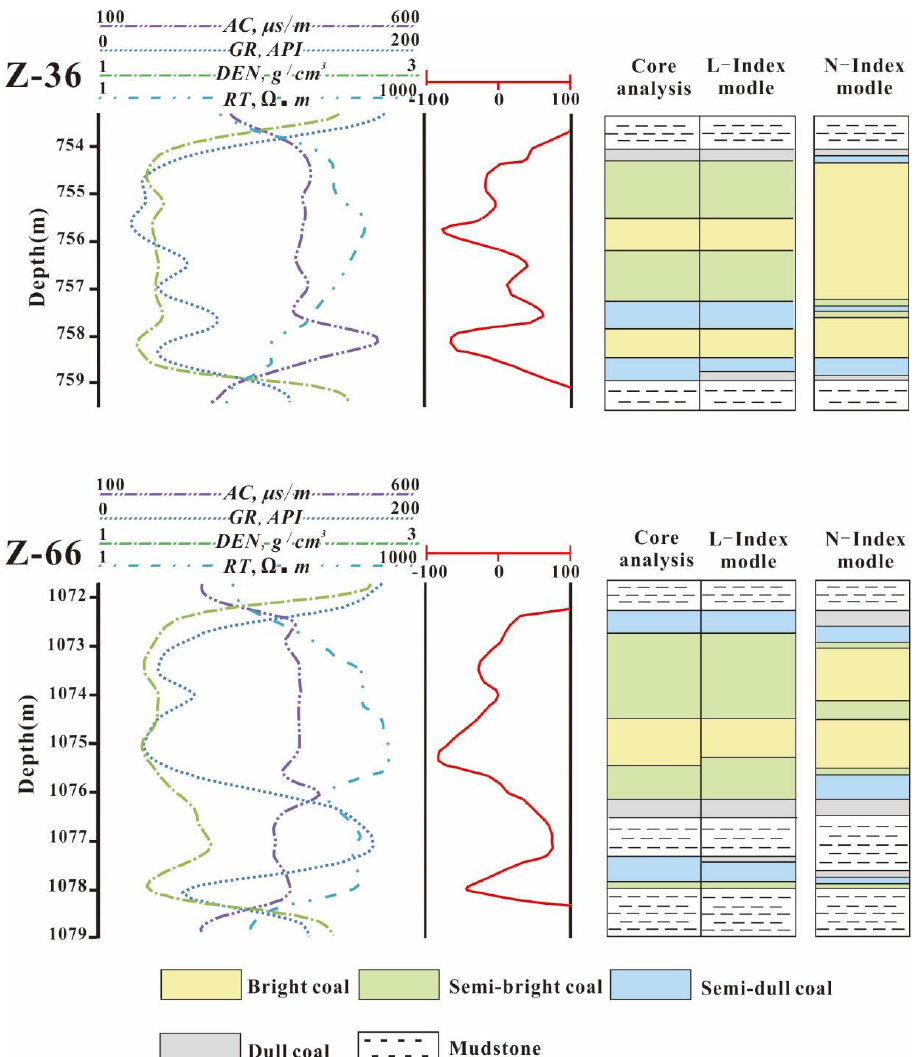
Figure 6. Comparison of results of coal macrolithotype identifications based on core analysis and the well logging interpretations for Well Z36 and Well Z66. The logging interpretations based on both the L-index model in this study and N-index model from Tao et al., 2019 [ 16 ], are presented.